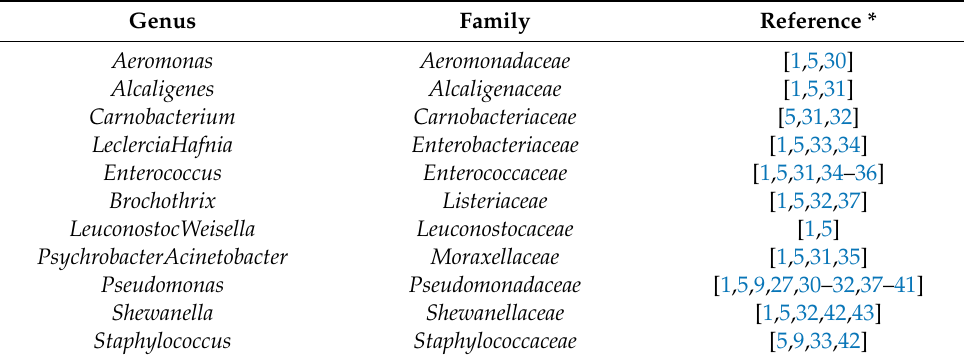
Table 1. List of bacterial groups associated to chicken meat